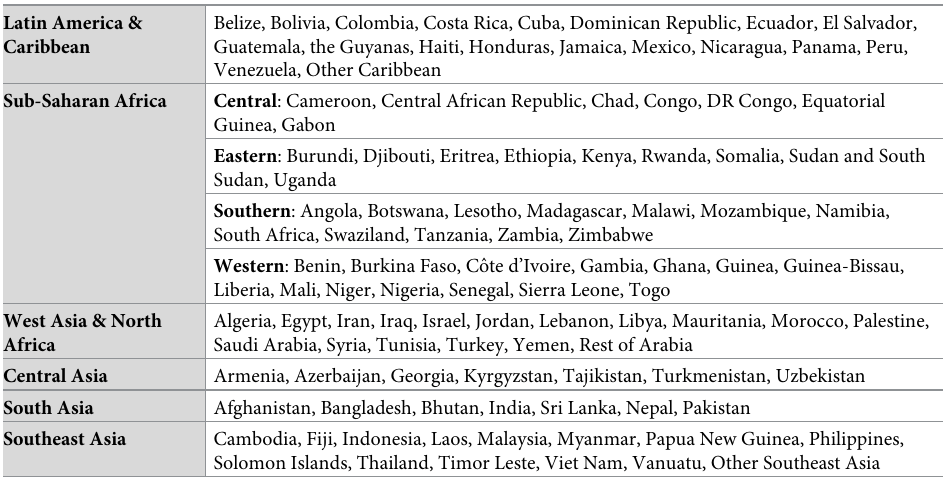
Table 2. Countries and regions included in the analysis.